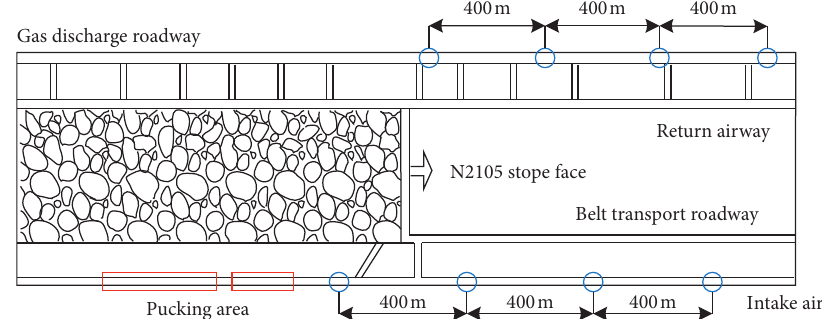
Figure 11: Installation plan of microseismic system.